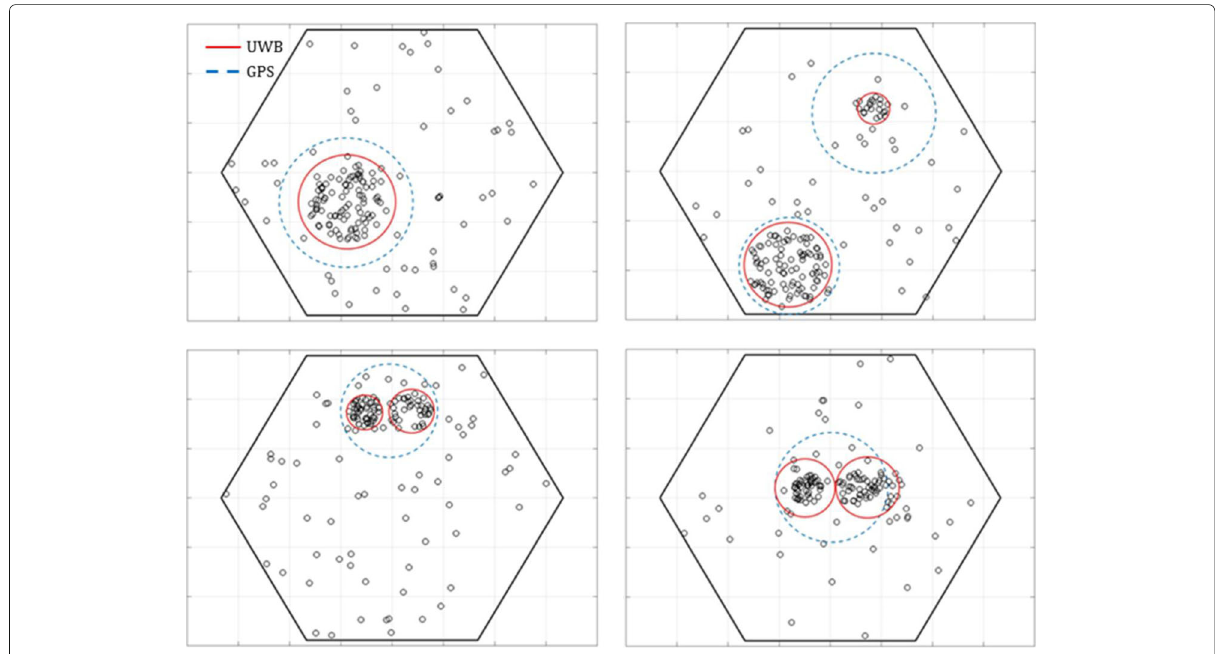
Fig. 15 Four representative clustering realizations. In this figure, four representative clustering realizations depending on UEs distribution are highlighted. Figure 13a (realization i .), GPS and UWB methods give us a hotspot where the one given by UWB signals has a smaller radius than the one given by the GPS. Figure 13b (realization ii .), both clustering methods detect this hotspot, its radius is much smaller using UWB method than GPS and also seems to be more dense. In Fig. 13c (realization iii .) and in Fig. 13d (realization iv .), by using GPS for hotspot detection only the predefined hotspot is detected by the method whereas UWB detects the two sub-hotspots. In Fig. 13d, UEs close to the predefined hotspot are taken into account by the UWB method and are included into the final